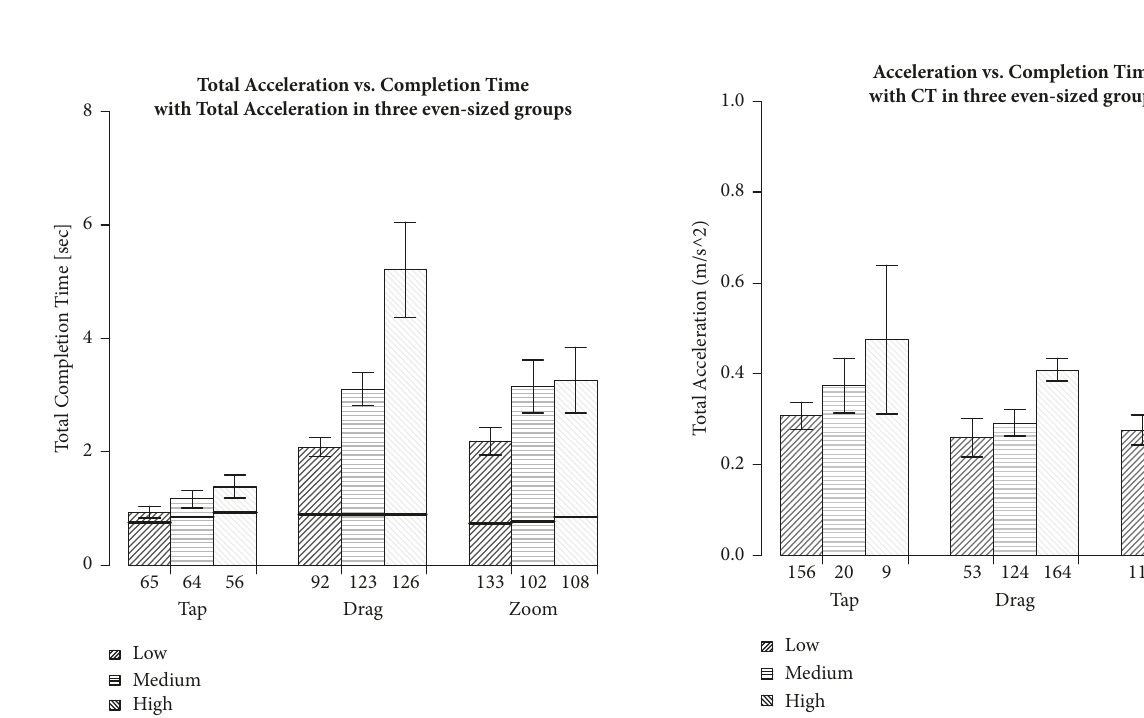
Figure 20: Completion time for the three task types depending on RMS of acceleration intensity. The number of samples is provided below the histograms. Horizontal bars denote the average time to first reaction.